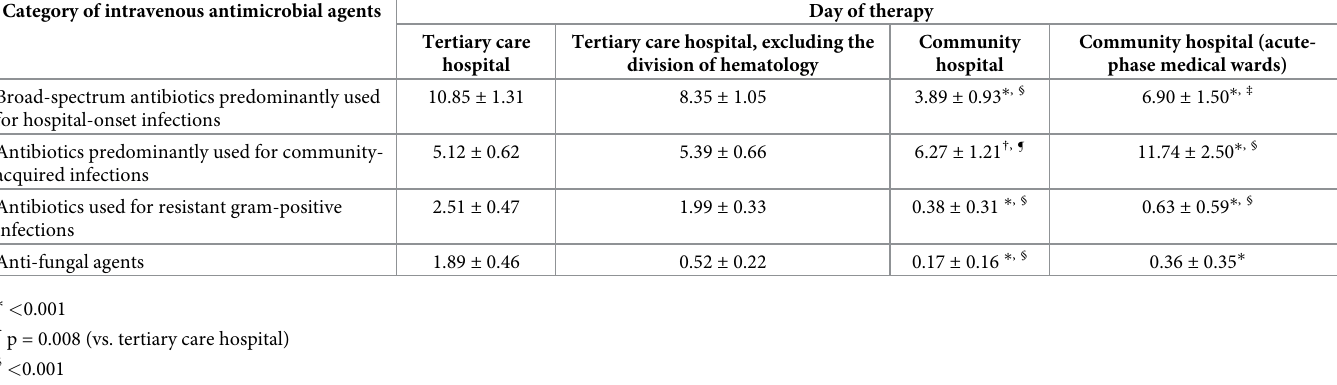
Table 1. Day of therapy of each category of intravenous antimicrobials in the tertiary care hospital and the community hospital between April 2021 and March 2022. Category of intravenous antimicrobial agents